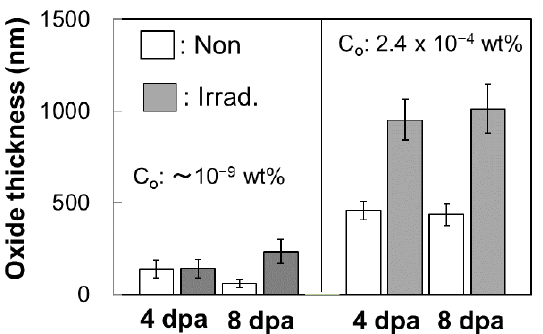
Figure 6. Oxide thickness of non-irradiated and irradiated areas after corrosion tests at low and saturated oxygen concentrations for 316L specimens irradiated at 4 and 8 dpa.